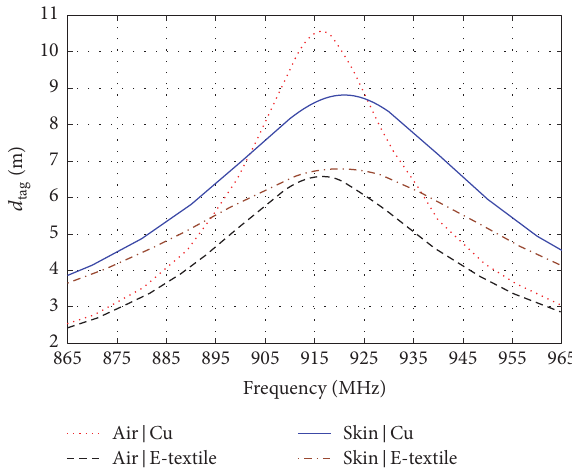
Figure 3: Simulated antenna-microchip power transfer efficiency. Figure 4: Simulated attainable read range of the tag under the